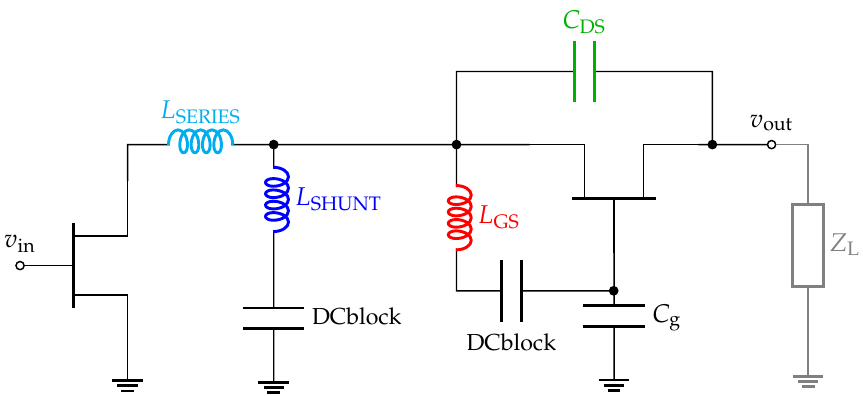
Figure 8. Most widely adopted inter-stage matching networks: series inductance (cyan), shunt inductance (blue), feedback capacitance (green) and gate-source inductance